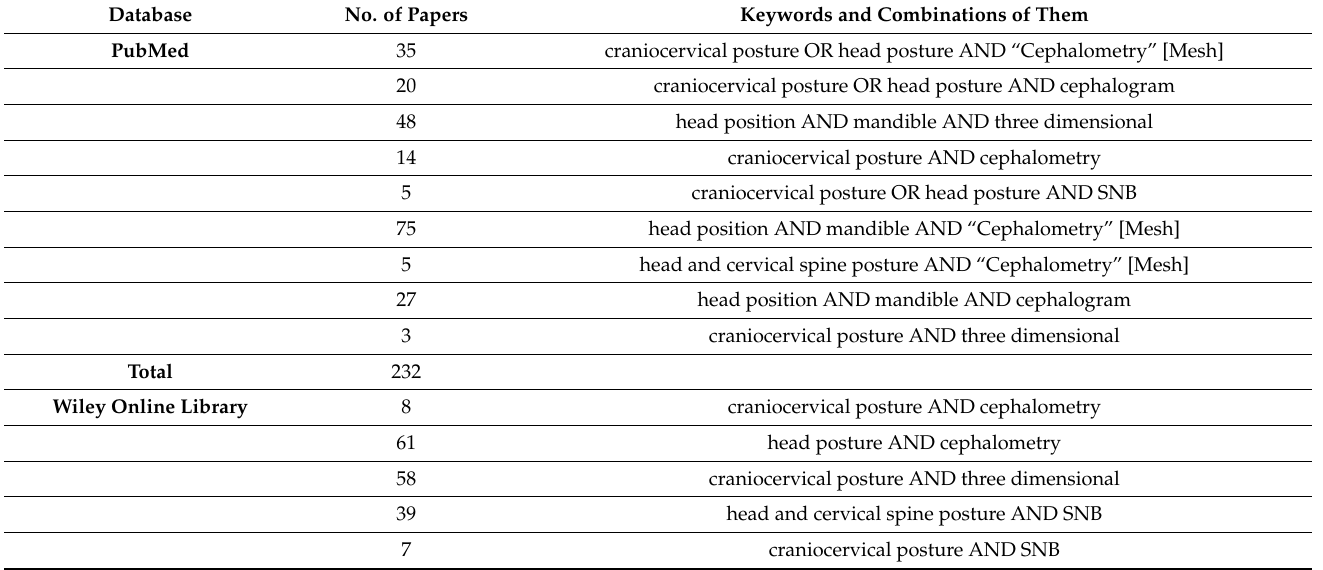
Table 1. Searched databases and combinations of